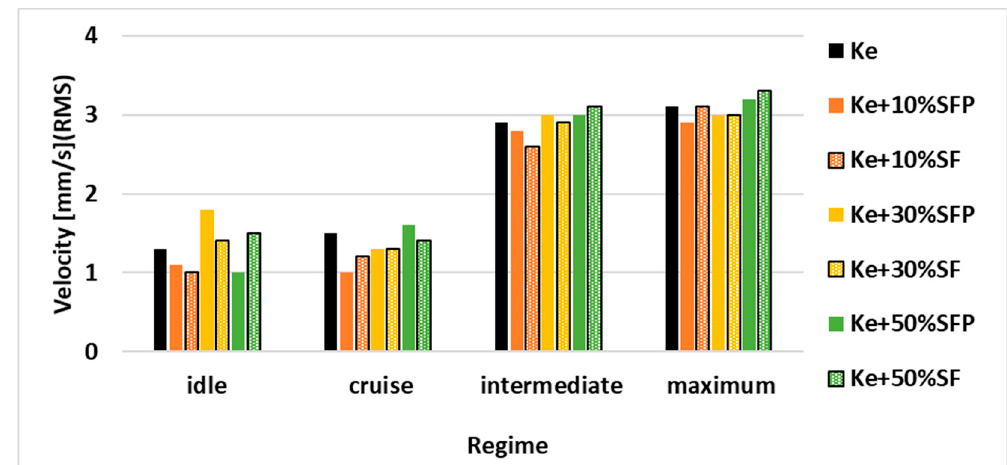
Figure 10. Radial vibration levels.